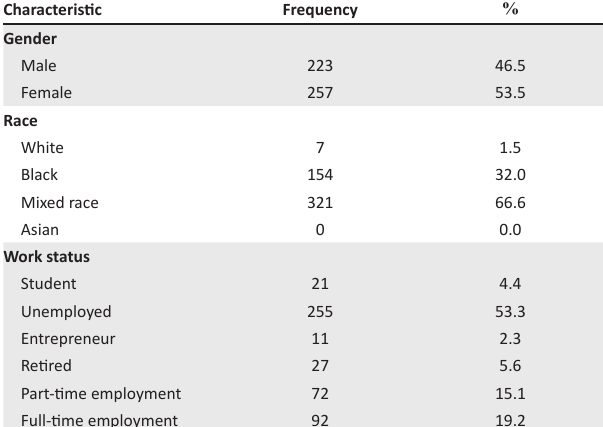
TABLE 1: Characteristics of the participants who took part in the quantitative phase of the study ( n = 483). Characteristic